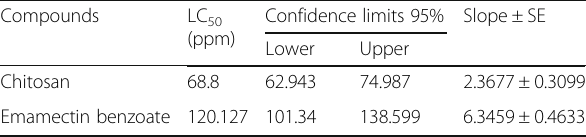
Table 1 LC 50 values of chitosan and emamectin benzoate against Eobania vermiculata using thin film technique Compounds LC 50